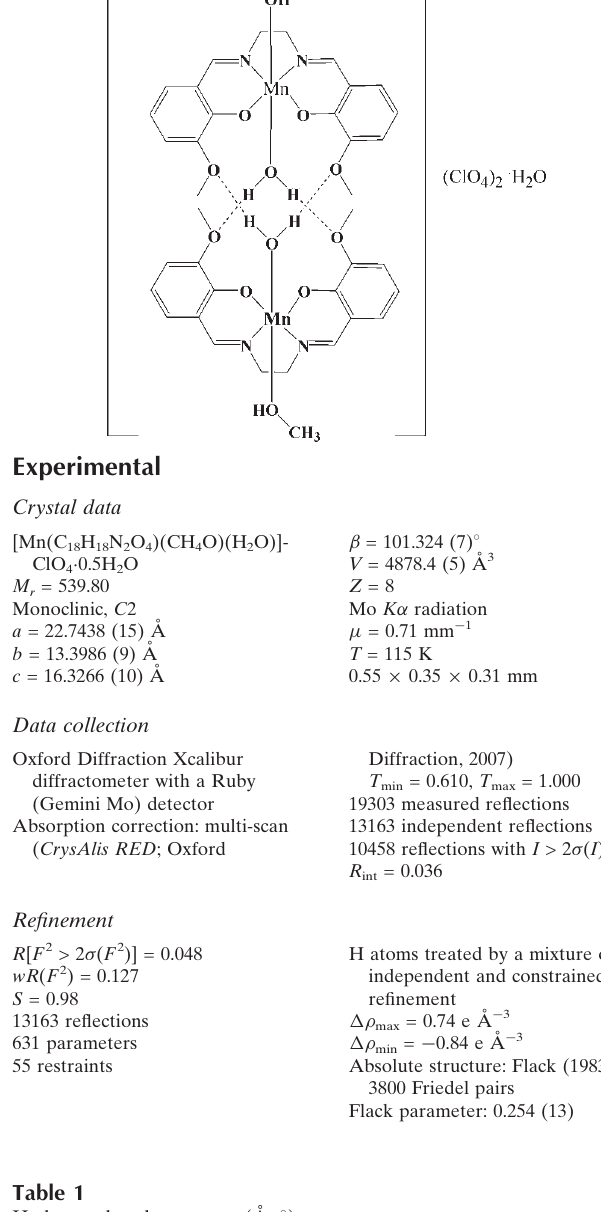
Hydrogen-bond geometry (A˚ , (cid:3)